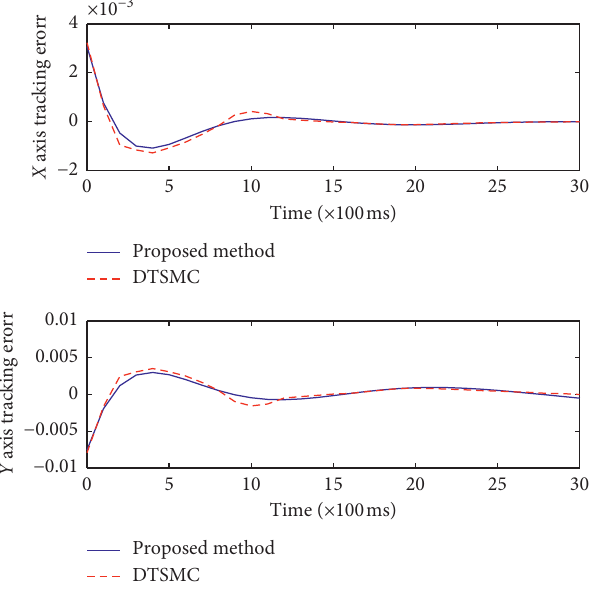
Figure 14: Comparative position tracking errors of the end